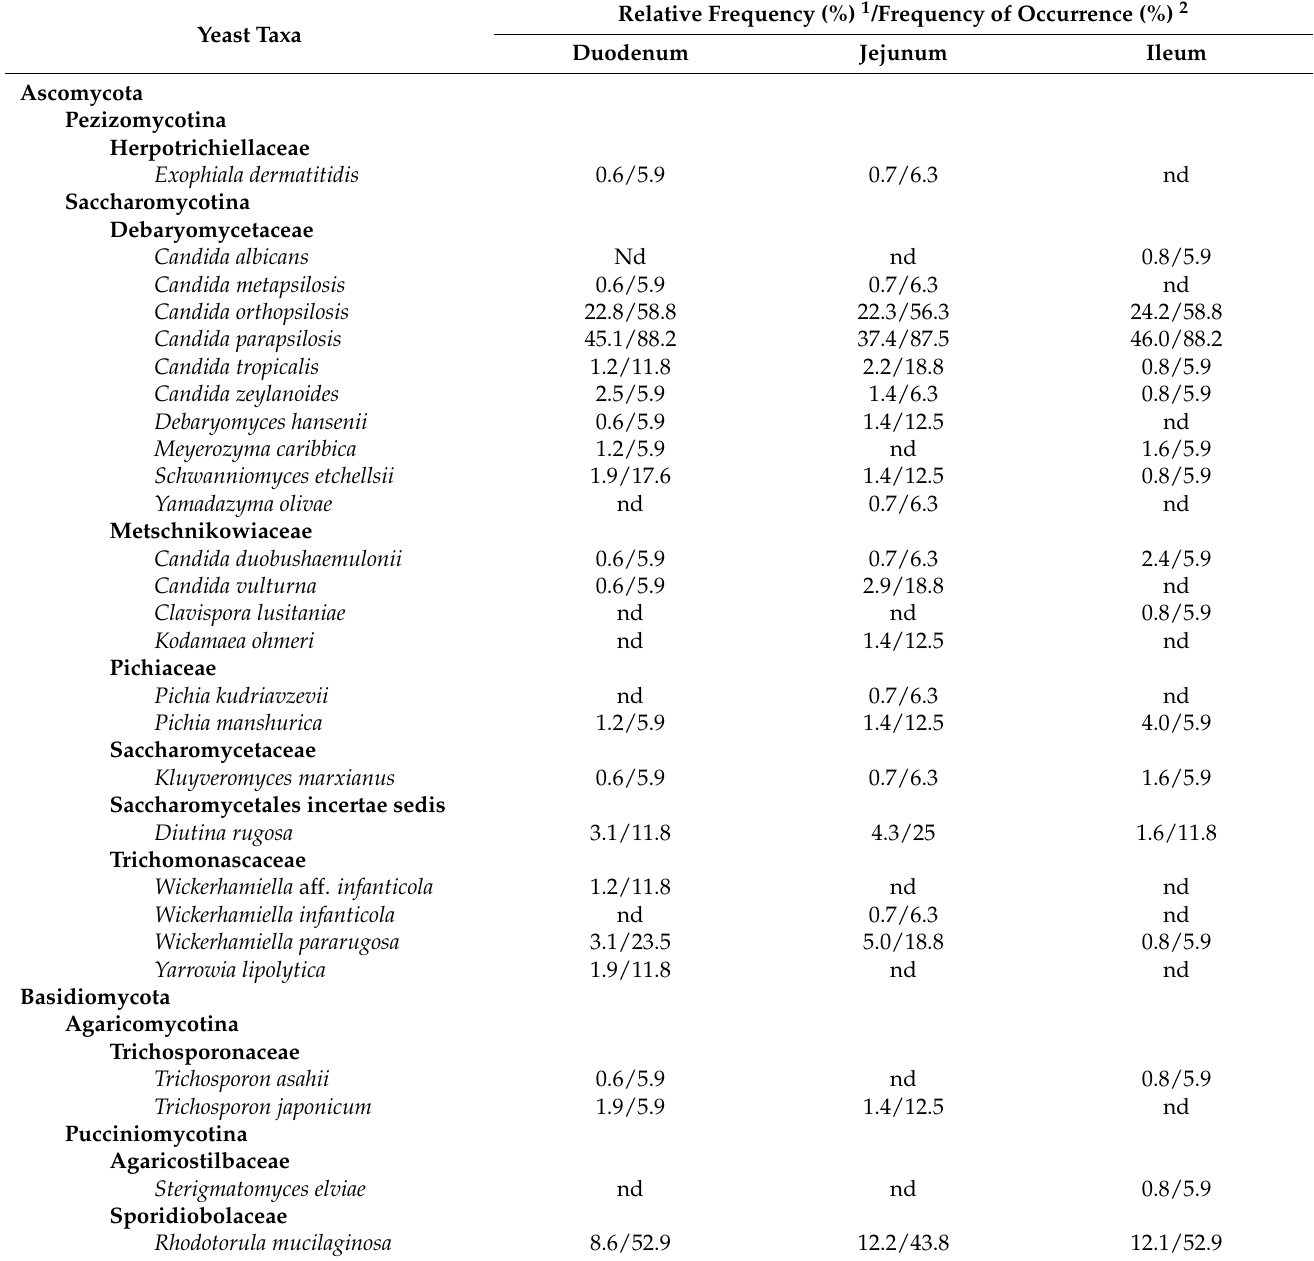
Table 4. Relative frequency and frequency of occurrence of yeasts isolated from small-intestinal